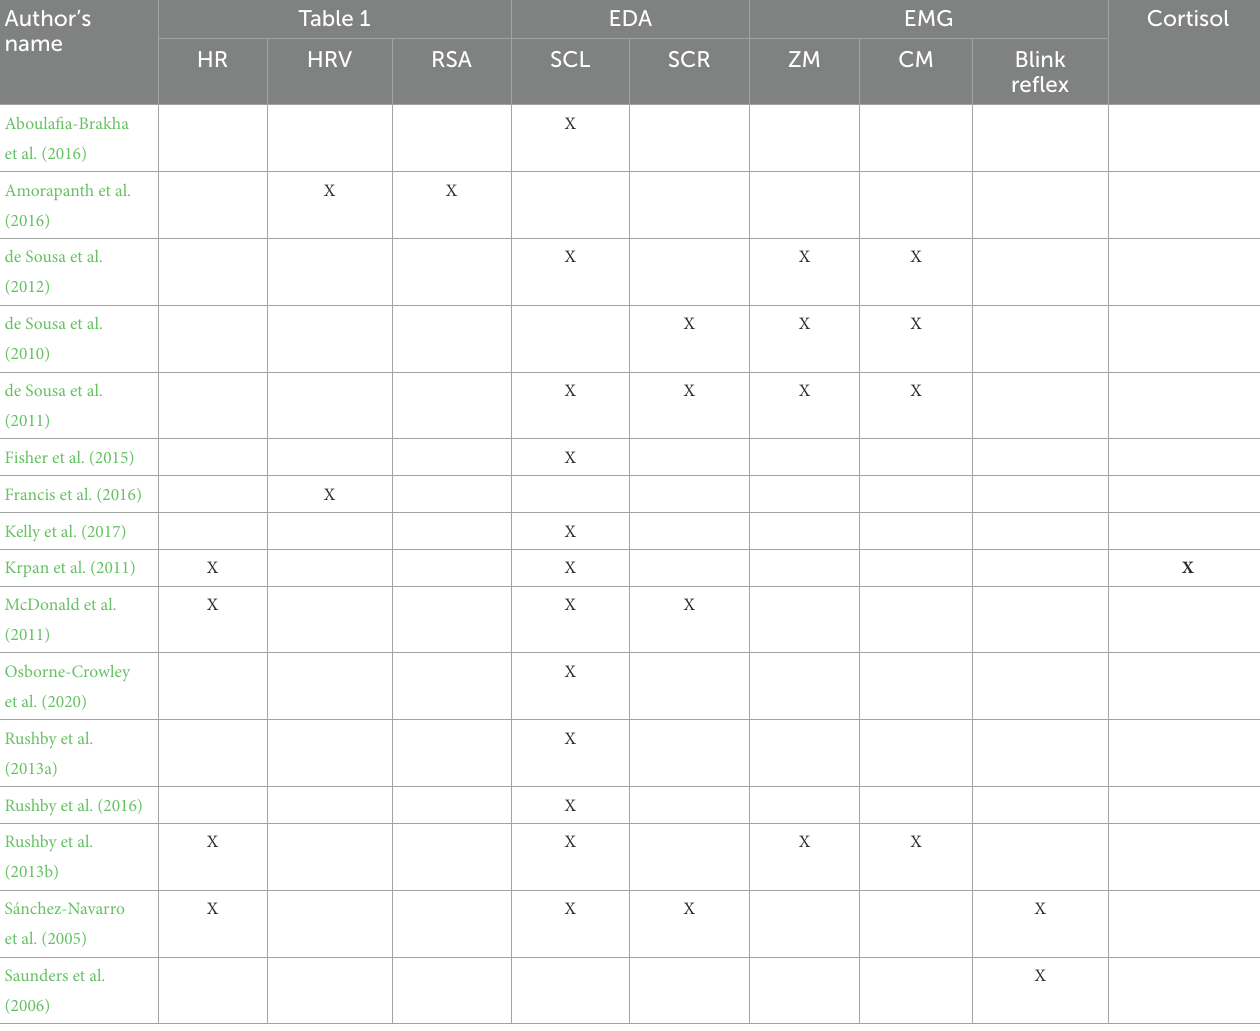
TABLE 3 Summary of physiological measurements by